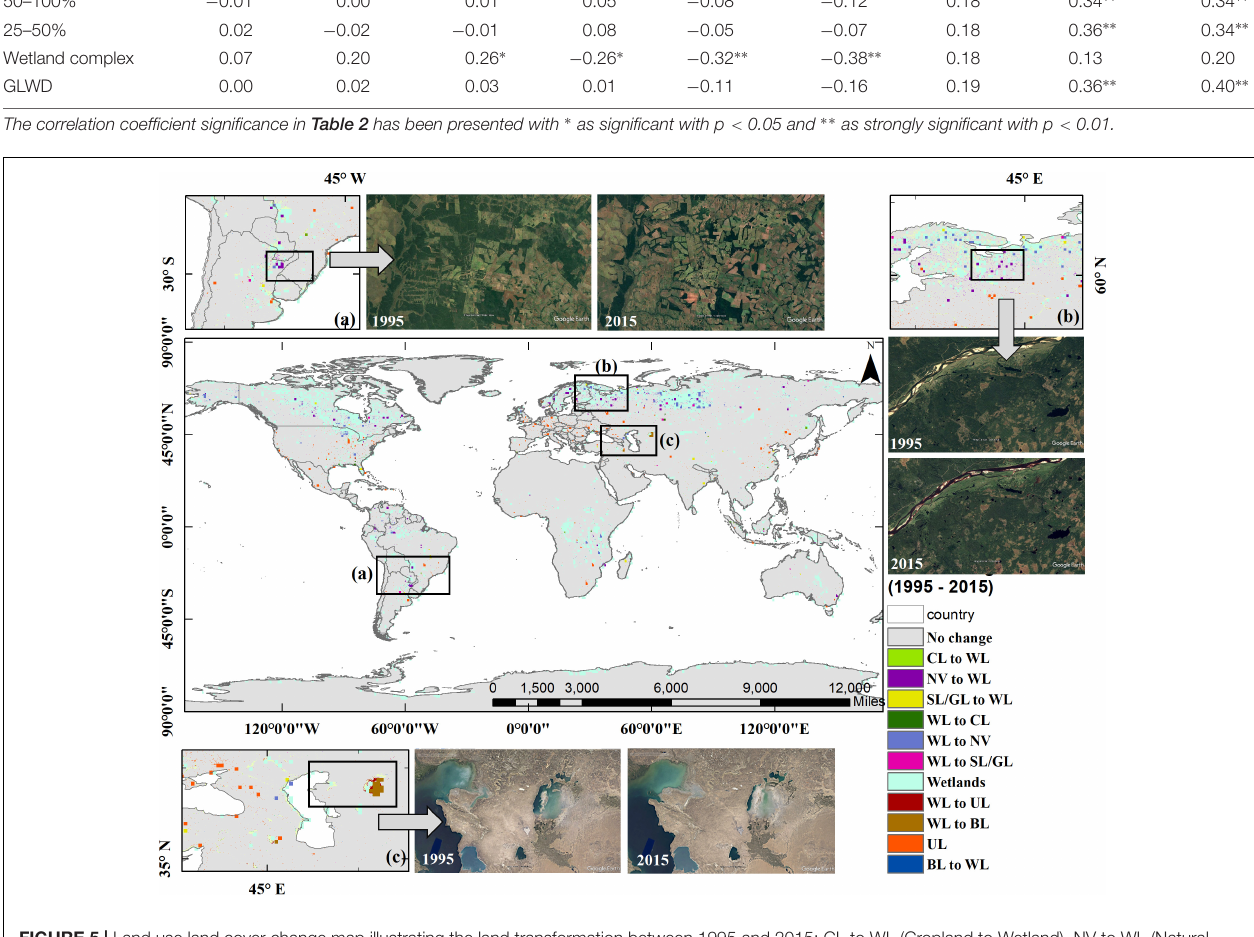
FIGURE 5 | Land use land cover change map illustrating the land transformation between 1995 and 2015; CL to WL (Cropland to Wetland), NV to WL (Natural Vegetation to Wetland), SL/GL to WL (Shrubland/Grassland to Wetland), WL to CL (Wetland to Cropland), WL to NV (Wetland to Natural Vegetation), WL to SL/GL (Wetland to Shrubland/Grassland), WL to UL (Wetland to Urban land), WL to BL (Wetland to Barren land), BL to WL (Barren land to Wetland), Wetlands, and UL (Urban Land). Where the conversion of natural vegetation to wetland has been shown in subplot (a) in the catchment area of the Paraná River located in the south-Central America, and subplot (b) of the catchment region of the Northern Dvina River in the Arkhangelsk Oblast region located in the north of European Russia; while the conversion of wetland area to barren land has been shown in subplot (c) shows the some part of Caspian Sea along with the areal coverage of Aral Sea of Central Asia besides each of the three subplots regions are shown through Google earth images from 1995 and 2015 to highlight the land use change as observed through the satellite imagery. Different wetland classes responded differently to the land use change, depending essentially on the deeper ecological and atmospheric connection between the two. Seven of the classes have shown high correlations (positive/negative) with the land use change drivers within the 10 km radius of each class. The significant correlation coefficients have been presented by rivers and reservoirs from open water bodies and swamps, coastal, 50–100% and wetland complex form the wetland classes. The summary of correlation coefficients for all the land use drivers with different wetland types has been presented in Correlation matrix; Table 3 .